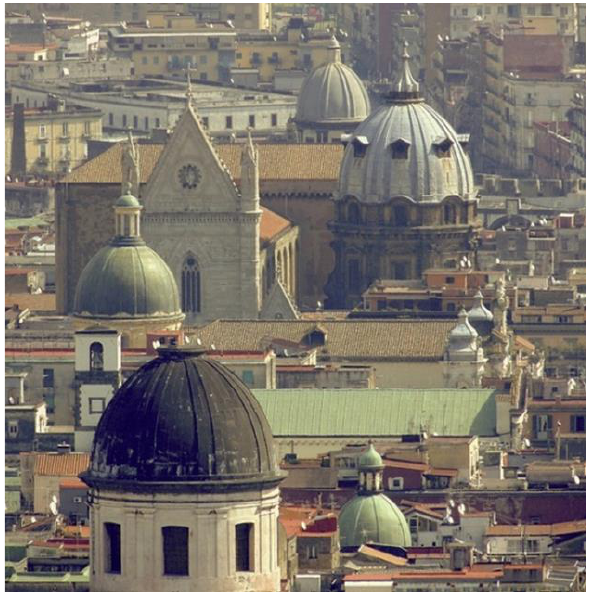
Figure 1. Naples, skyline. In the background, the high Treasury of San Gennaro Chapel and the Church of Santa Caterina a Formiello dome at the back.